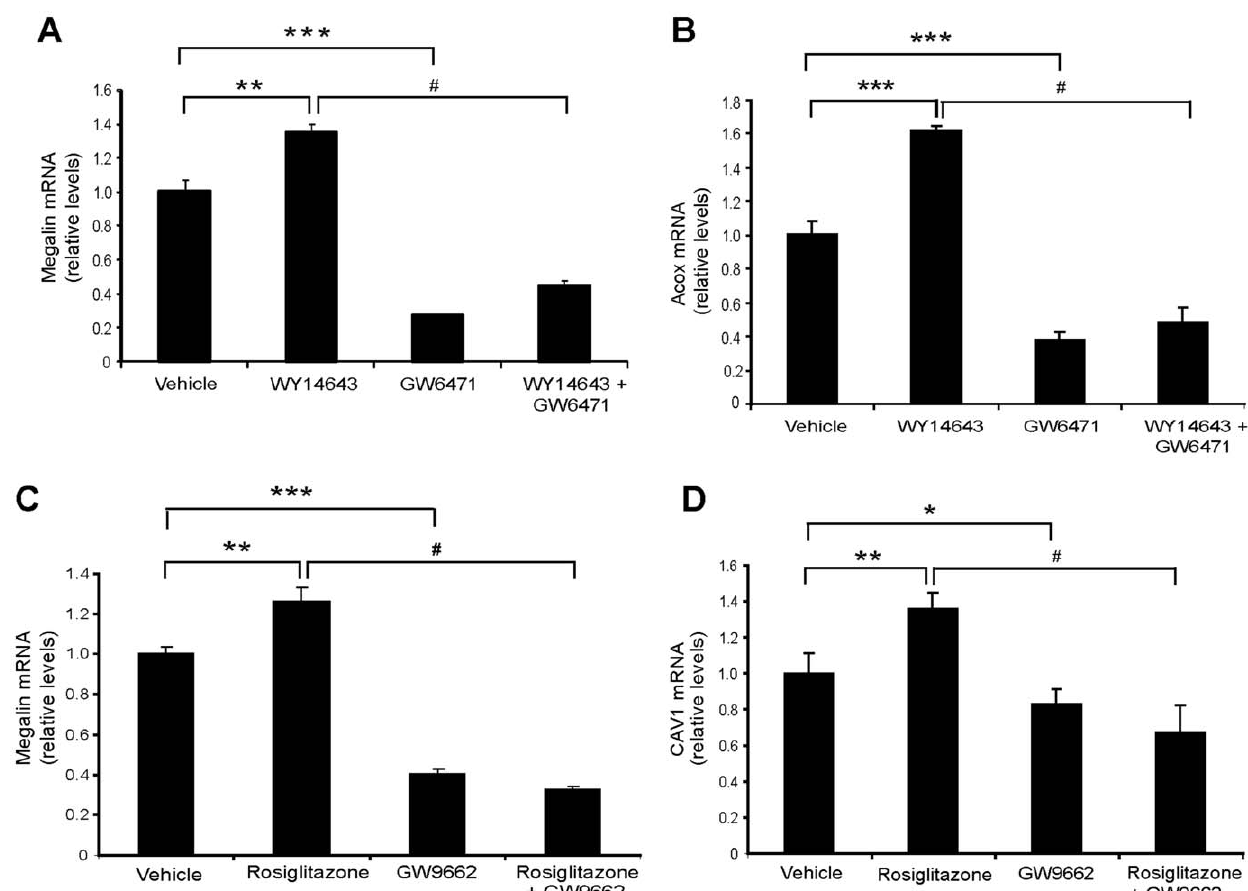
Figure 3. PPAR a and PPAR c agonists or antagonists regulate megalin mRNA expression in LLC-PK1 cells. ( a, b ) LLC-PK1 cells were treated with 100 m M WY 14643 (PPAR a agonist), 10 m M GW 6471 (PPAR a antagonist) or both drugs for 24 h. Megalin and Acox mRNA levels were determined by qPCR, and values were normalized to the housekeeping gene actin (n=4). ( c, d ) LLC-PK1 cells were exposed to 1 m M rosiglitazone (PPAR c agonist), 10 m M GW 9662 (PPAR c antagonist) or both drugs for 24 h. Megalin and caveolin 1 mRNA levels were detected by qPCR, and values were normalized to the signal from the housekeeping gene actin (n=4). Results are expressed as means 6 standard deviation (SD). Statistically significant differences compared to the control (DMSO, vehicle) are indicated by *P , 0.02, **P , 0.01, ***P , 0.001. Statistically significant differences to the agonist alone are indicated by # P , 0.001.